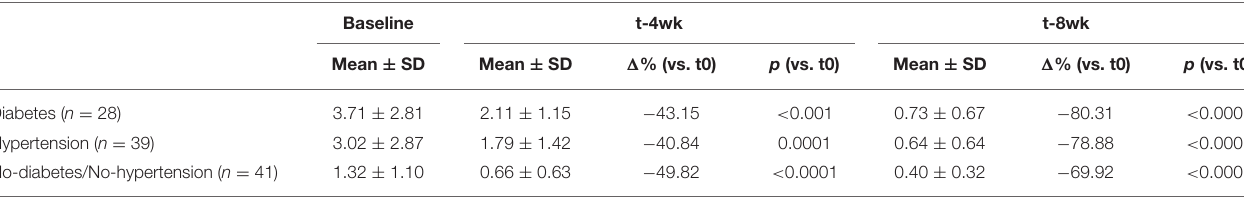
TABLE 3 | Serum levels of TMAO before and after 4-week and 8-week treatment with Taurisolo ® in study participants stratified for diagnosis of diabetes or hypertension.